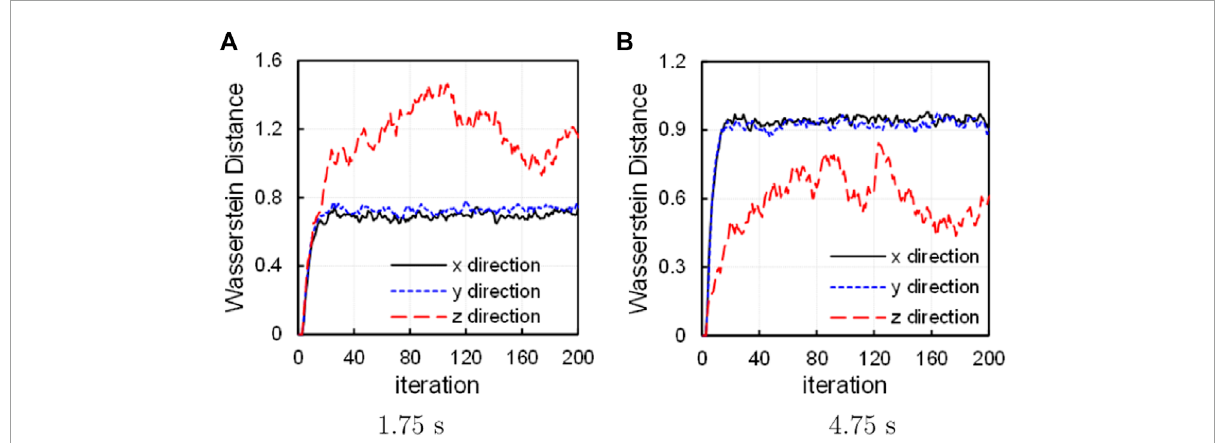
FIGURE 8 WD curves at (A) 1.75 s and (B) 4.75 s, without ASM.